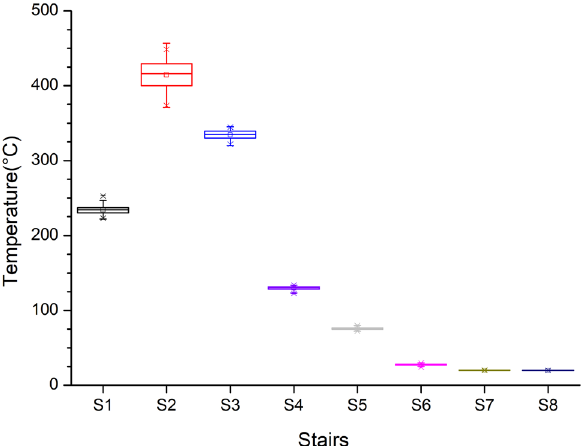
Figure 16. Temperature variation of B1 entrances at different stairs (for Case Tc_Wtc_B1o).